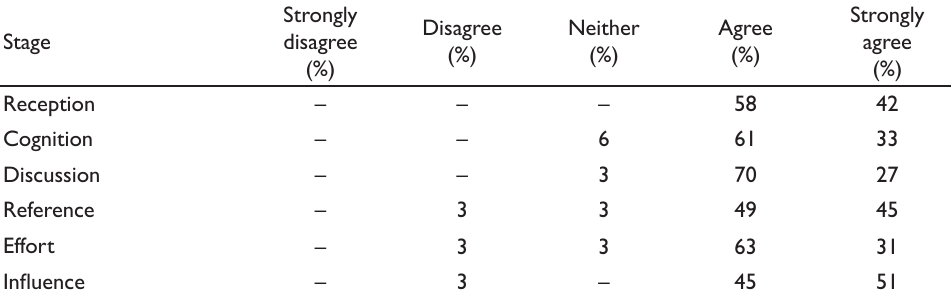
Table 1: Findings from the adapted ‘ladder of use’ scale (n=33)